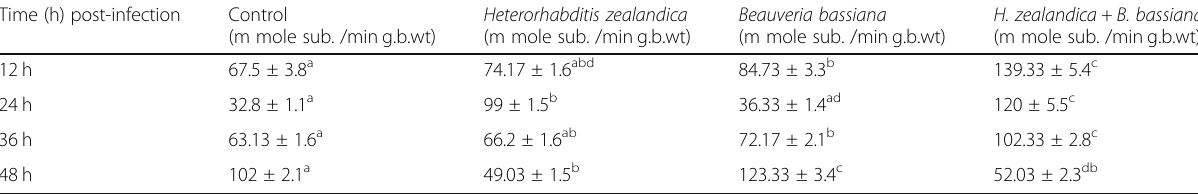
Table 4 Changes in glutathione S-transferase activity in the hemolymph of last instar Galleria mellonella larvae infected with Heterorhabditis zealandica , Beauveria bassiana , and their combination Time (h) post-infection Control Heterorhabditis zealandica (m mole sub. /min g.b.wt) (m mole sub. /min g.b.wt)